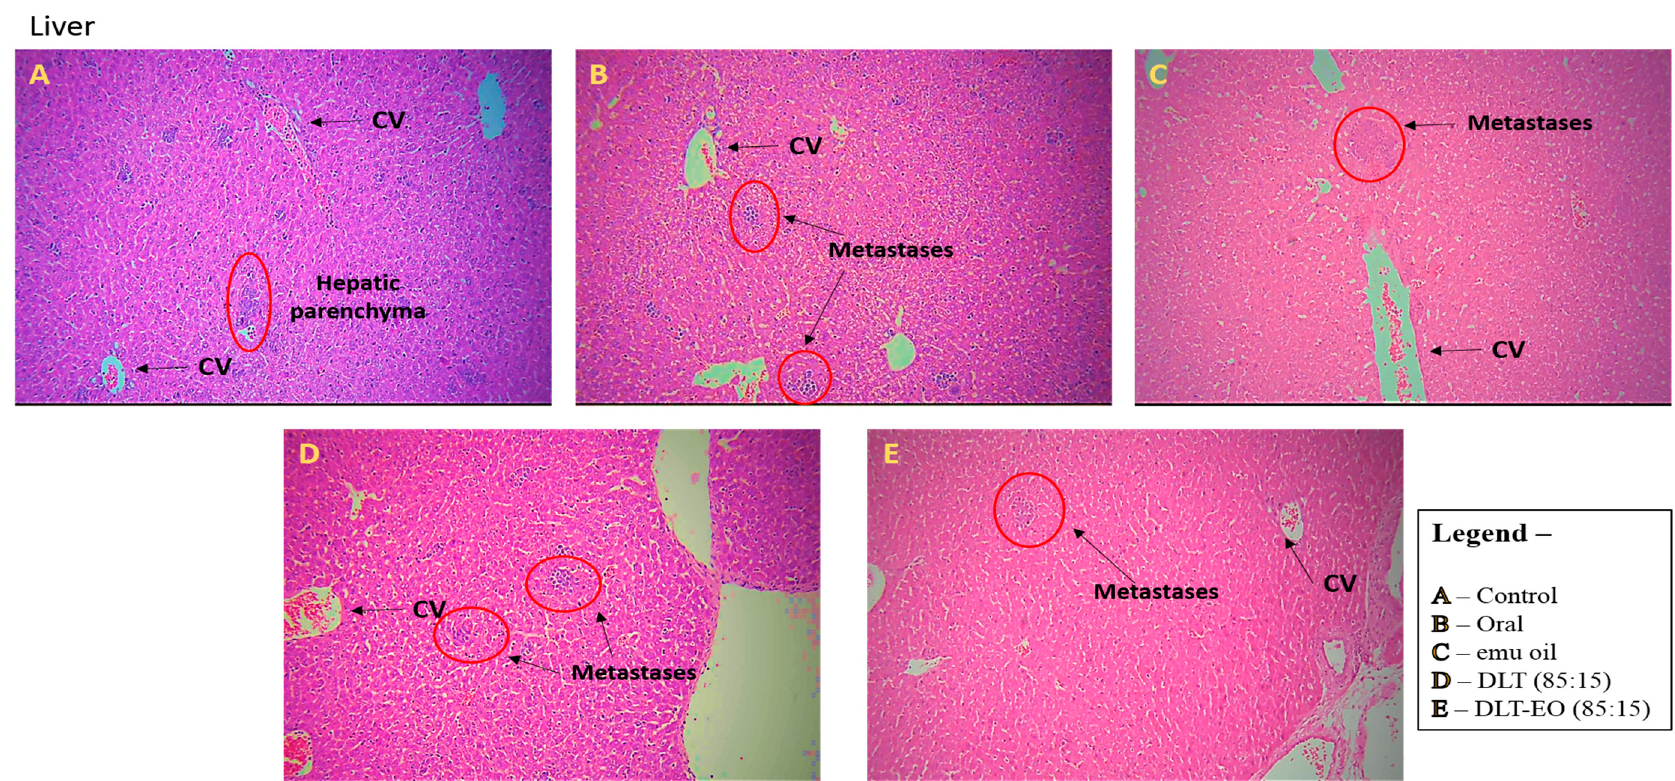
Figure 5. Photomicrographs from the liver of the ( A ): control (untreated), ( B ): orally treated (TAMX), ( C ): topically treated with emu oil (without the presence of drugs), formulations; ( D ): DLT (85:15) and ( E ): DLT–EO (85:15) at day 18 post treatment. H&E magnification 100× Note: DLT—deformable liposomes, DLT–EO—deformable liposomes with emu oil, CV—central vein.